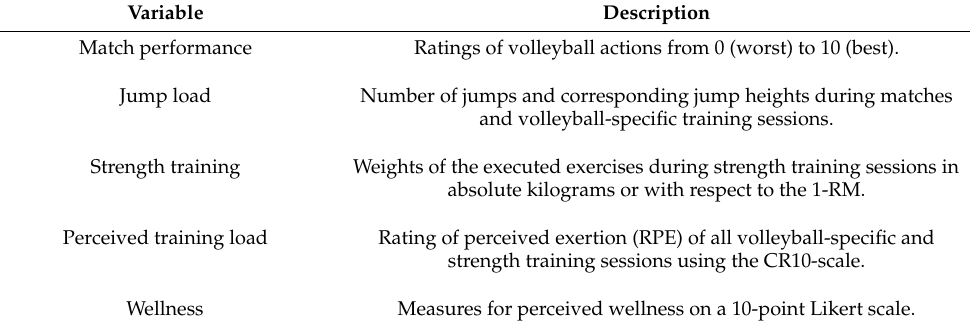
Table 1. Overview of most relevant groups of variables.